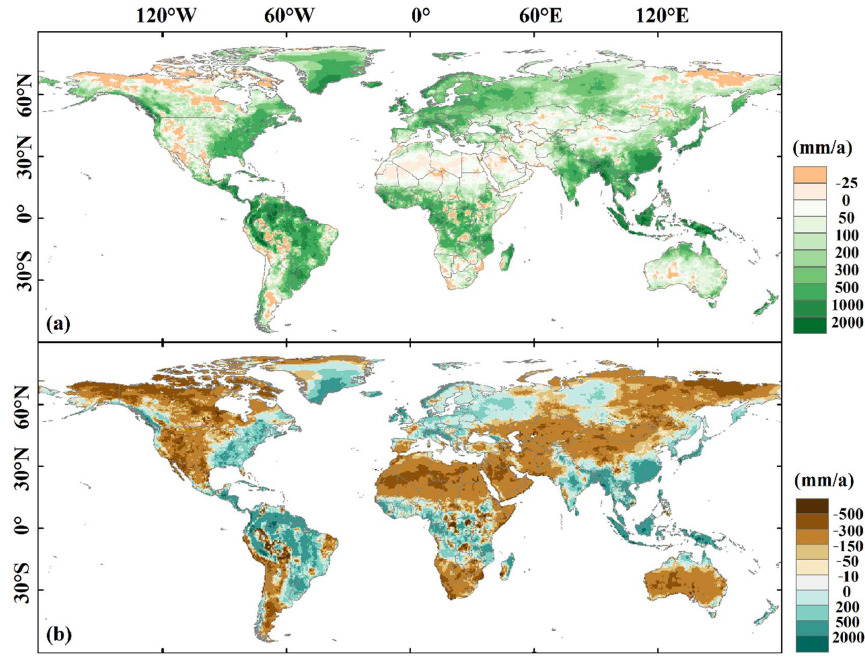
Figure 2. Geographic distribution of ( a ) the multi-year average values of annual terrestrial water yield during 1981−2018 and ( b ) its spatial anomalies.